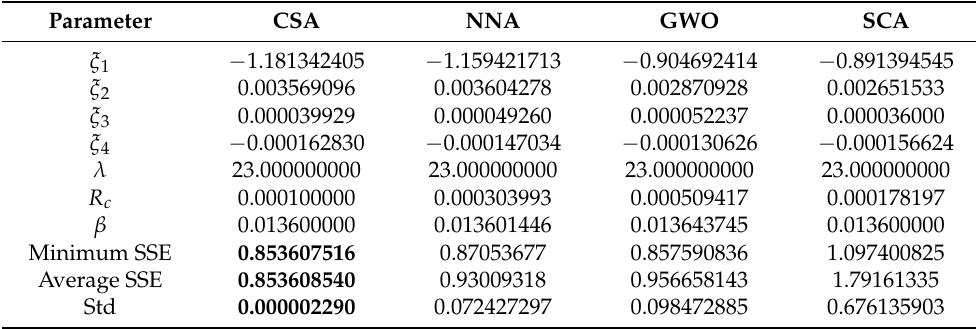
Figure 5. Convergence curve of fitness function for Ballard fuel cell. Table 2. Optimal parameters of Ballard PEMFC model.